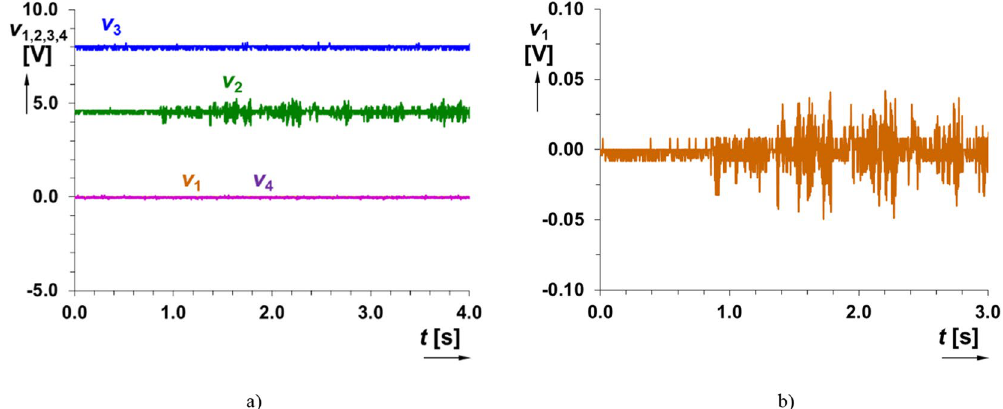
Figure 6. Time domain response of the readout system on talking (voice signal with low level): ( a ) all indicated intermediate and output voltages of the system, ( b ) detail on the signal at the output of microphone ( v 1 ( t